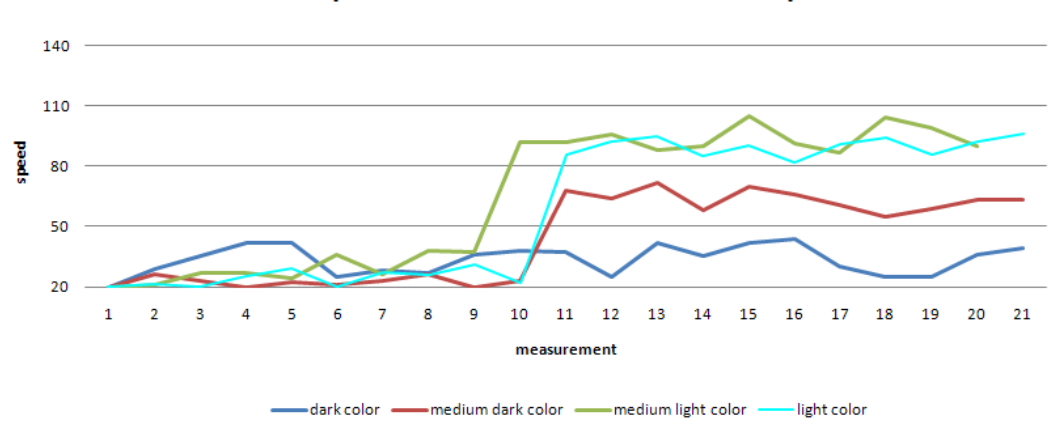
Figure 10. Speed of a mobile sensor with lower randomness learns from its peer with higher randomness.